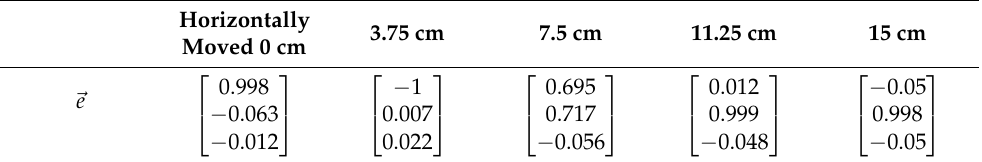
Table 3. eigenvector corresponding to maximum eigenvalue of (cid:60) ( Ψ ) when there is only Rx 1 on charging space.